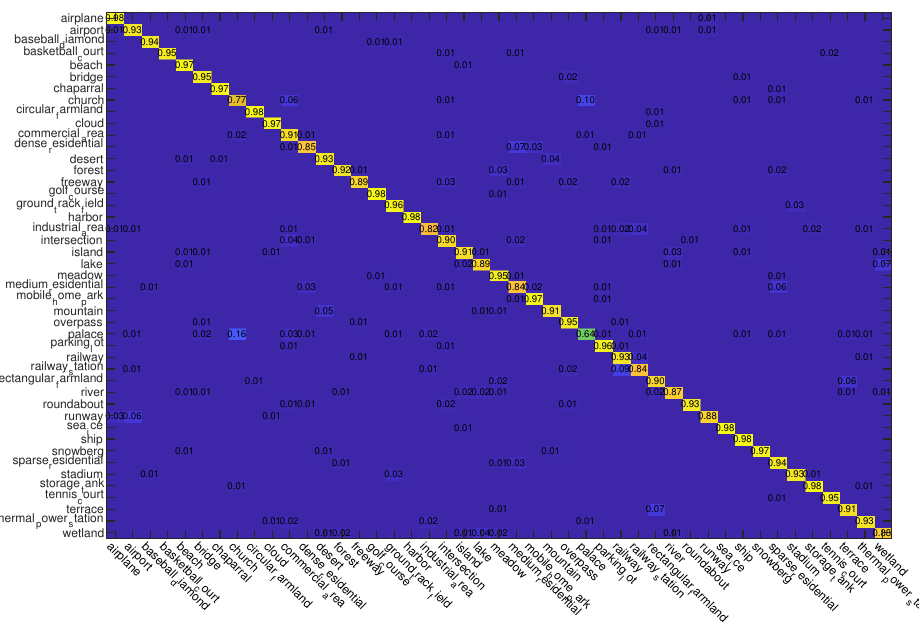
Figure 8. Confusion matrices obtained by ADRL-Net with ResNet50 as backbone on NWPU dataset (Picture can be enlarged by scaling the document). Tr =